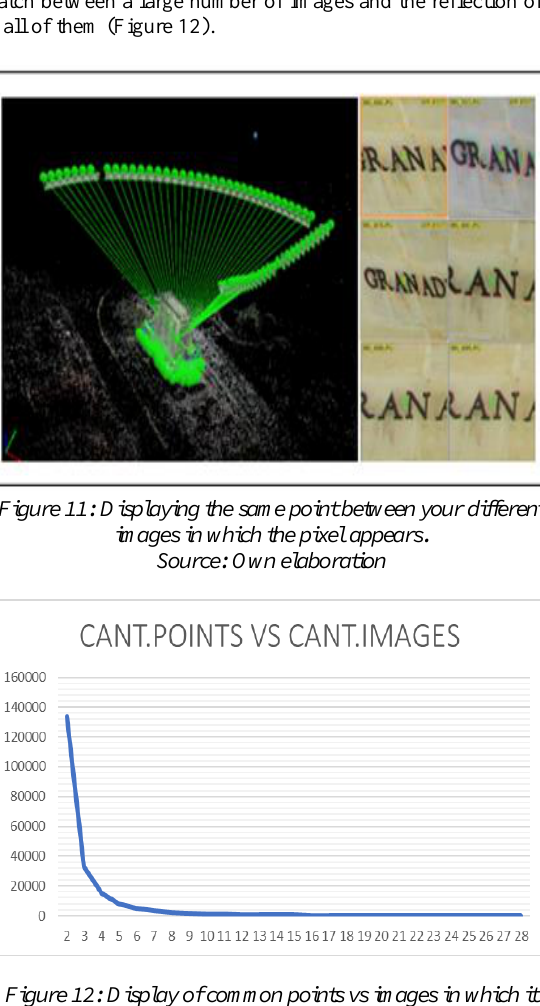
Figure 12: Display of common points vs images in which it